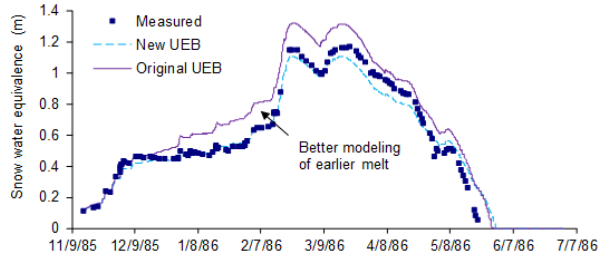
Figure 11. Comparisons of meltwater outflow rate in 1986 at CSSL.